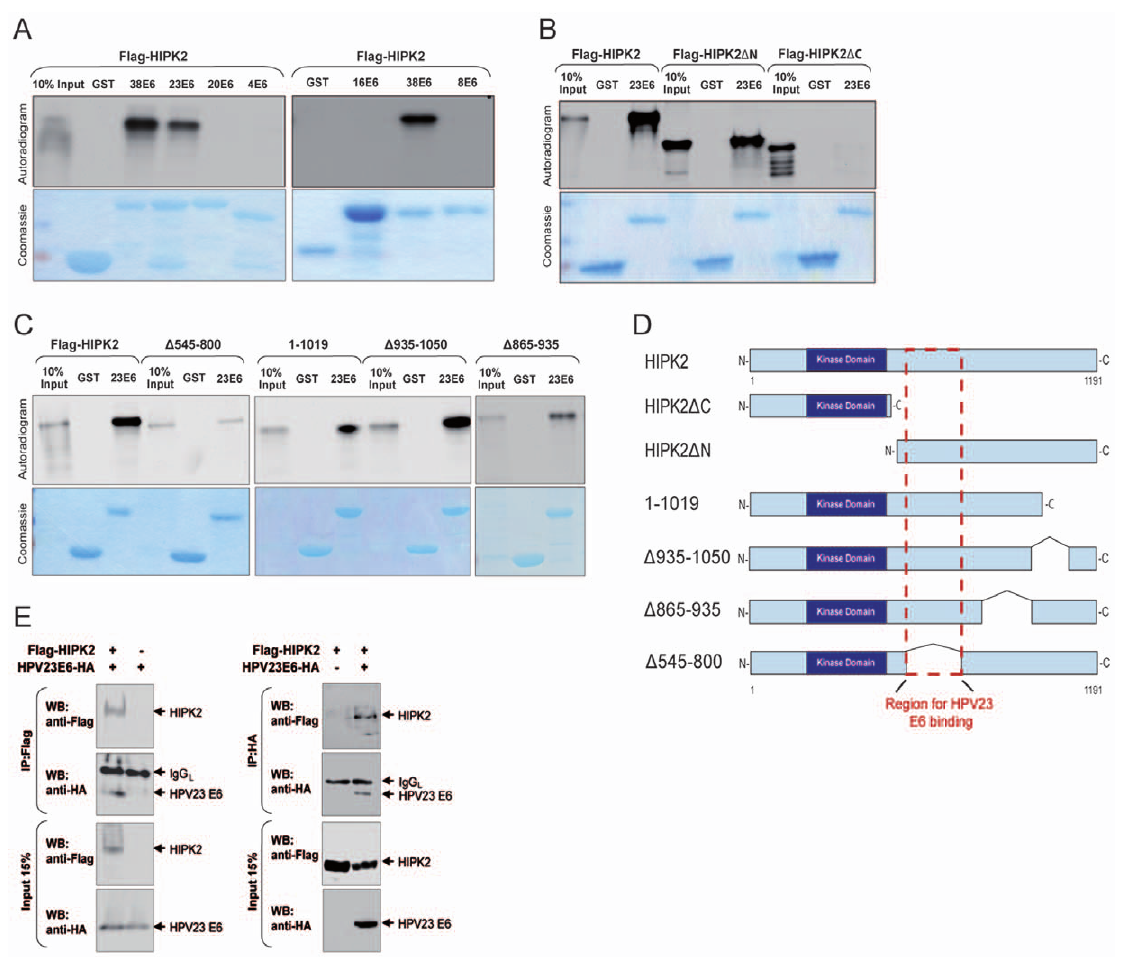
Figure 1. HIPK2 and HPV23 E6 proteins interact invitro and invivo . ( A–C ) GST and various GST-tagged HPV E6 proteins were incubated with in vitro translated 35 S-labelled HIPK2 protein. GST was used as a negative internal control. GST pull-down experiments were analyzed by SDS–PAGE and stained with Coomassie brilliant blue to estimate the protein concentrations (lower panels). One-tenth of the total 35 S-labelled HIPK2 input was applied to the SDS-PAGE. Gels were dried and exposed to X-ray films and autoradiograms are shown in the upper panels. ( A ) HPV38 E6 and HPV23 E6 proteins (cutaneous beat2PV) interact with HIPK2. HPV16 E6 (alphaPV), HPV4 E6 (gammaPV), HPV8 E6, and HPV20 E6 (cutaneous beta1PV) failed to physically interact with HIPK2. ( B ) HPV23 E6 proteins interact mainly with the C-terminus of HIPK2 (HIPK2 D N). ( C ) HPV23 E6 proteins showed reduced binding to the C-terminal deletion mutant D 545–800 of HIPK2. ( D ) Schematic presentation illustrates the full-lenght and deletion mutants of HIPK2, analyzed in GST pull-down experiments. The HIPK2 kinase domain and the predicted HPV23 E6 binding region are indicated. ( E ) HPV23 E6 bind in vivo to HIPK2 in H1299 cells, which were transfected with HA-tagged HPV23 E6 and Flag-tagged HIPK2 either alone or in combination and immunoprecipitated (IP) with Flag (M2) or HA (clone 12CA5) antibodies. Immunoprecipitated protein complexes were analyzed by Western blot (upper panels). The light chain of the precipitating antibody (IgG L ) is indicated. In the lower panels the expressed proteins levels of HIPK2 and HPV23 E6 in H1299 cells are